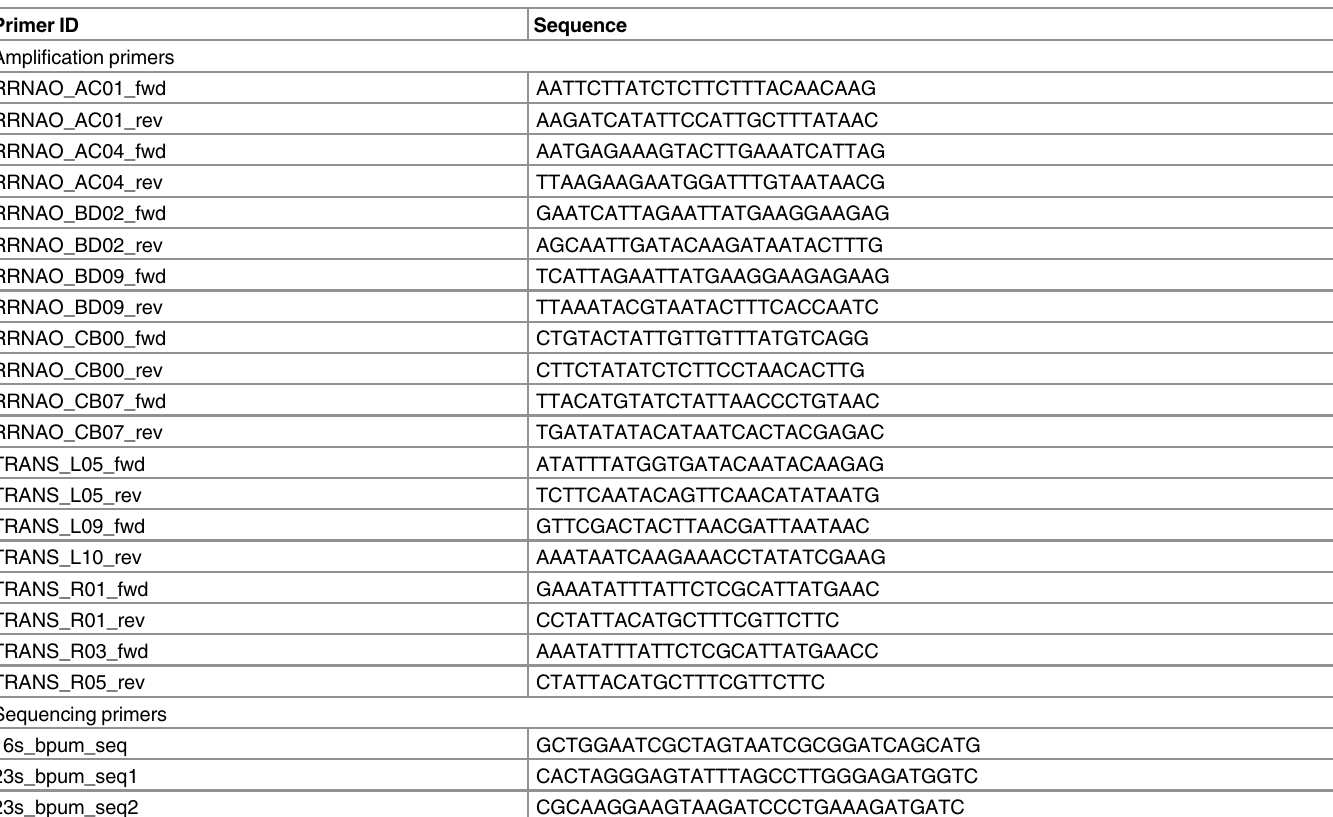
Table 1. Amplification and sequencing